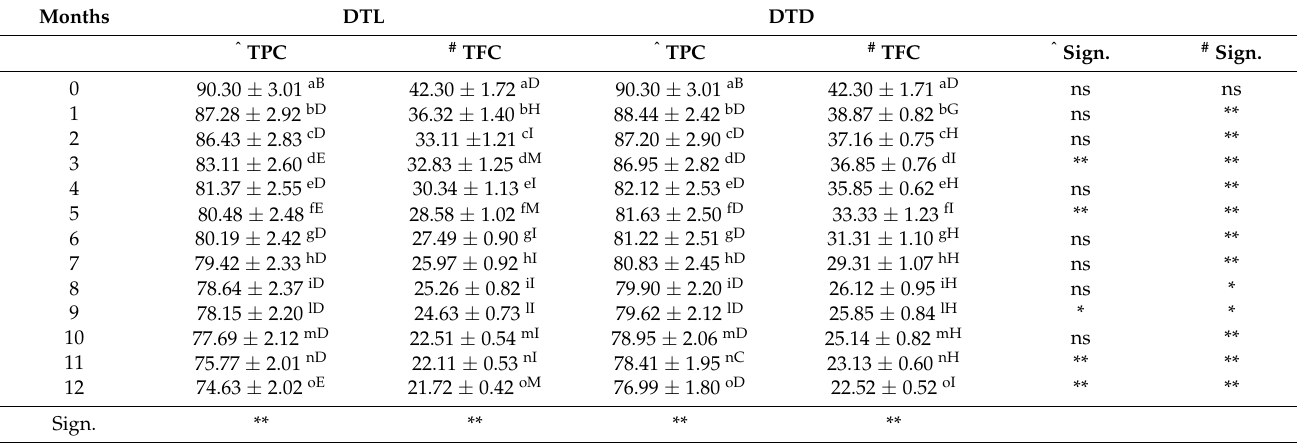
Table 7. TPC (mg CAE/g) and TFC (mg QE/g) content in DTL and DTD